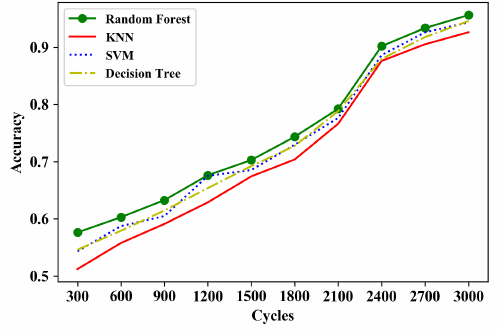
Figure 8. The prediction performance comparison